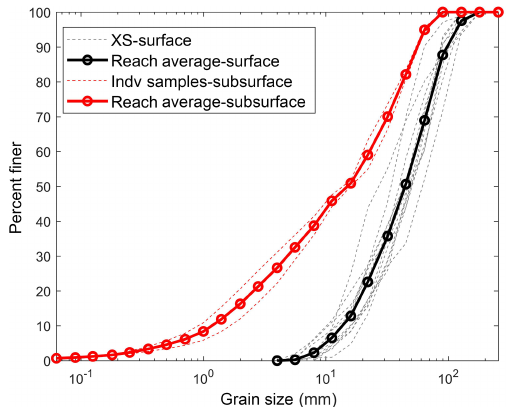
Figure 2. Surface and subsurface grain size distribution (GSD). The average surface GSD is based on 23 cross sections (XS) and average subsurface GSD based on two samples of the substrate collected from exposed